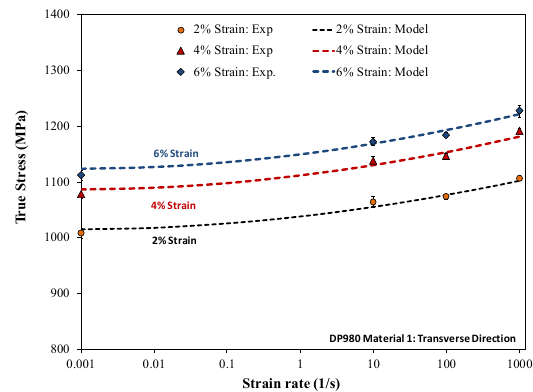
Fig. 16. Experimental rate sensitivity of Material 1 compared to the CS model